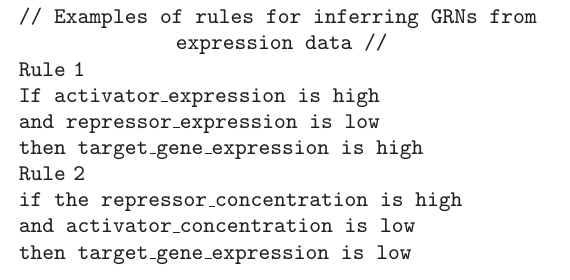
Algorithm 2: Predicting changes in gene expression